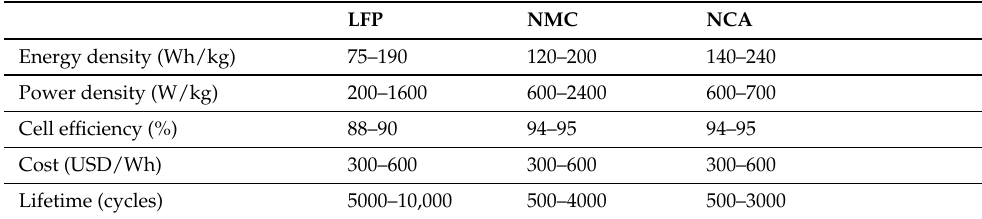
Table 4. Performance ranges for lithium iron phosphate (LFP), lithium nickel manganese cobalt (NMC), and lithium nickel aluminum cobalt (NCA) BESSs